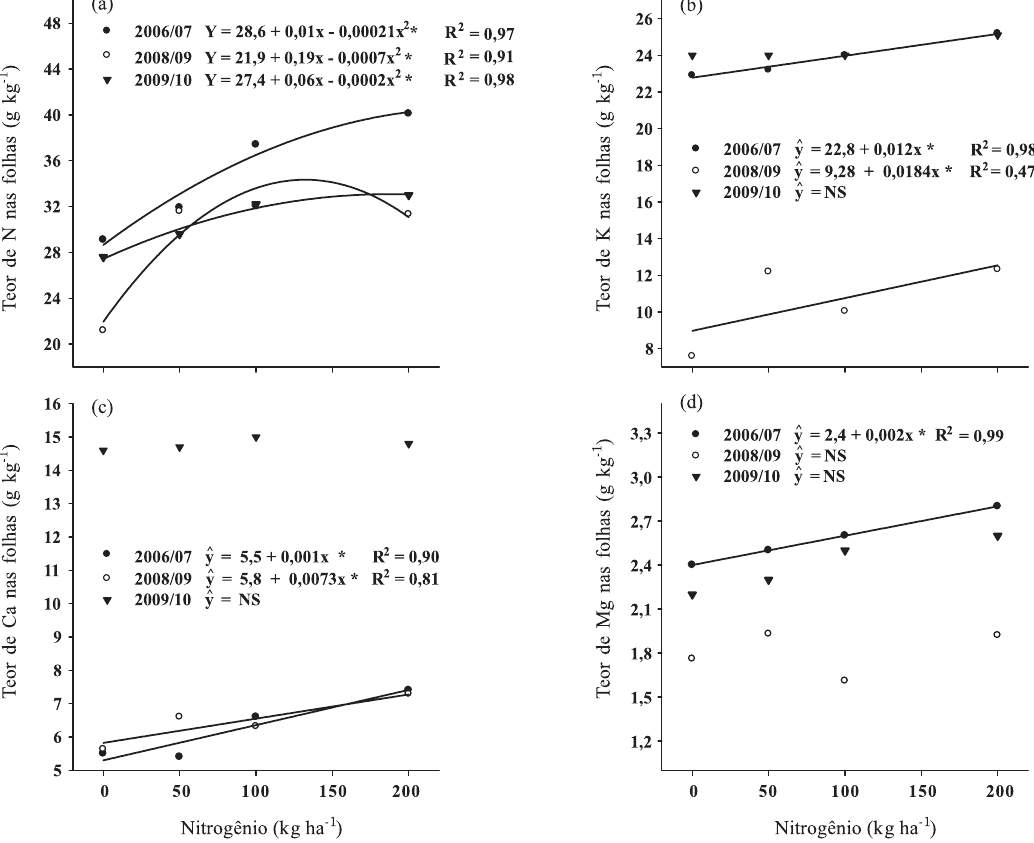
Figura 4. teor de nitrogênio (a) potássio (b), cálcio (c) e magnésio (d) nas folhas de cebola em função da adição de doses crescentes de nitrogênio ao solo, em duas safras. *: significativo (p ≤ 0,05); ns: não